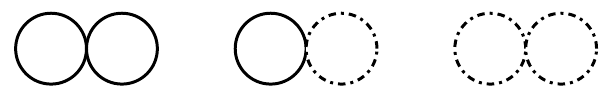
Figure 3 . Bubble diagrams contributing to ∆ ˆ Z at lowest order.